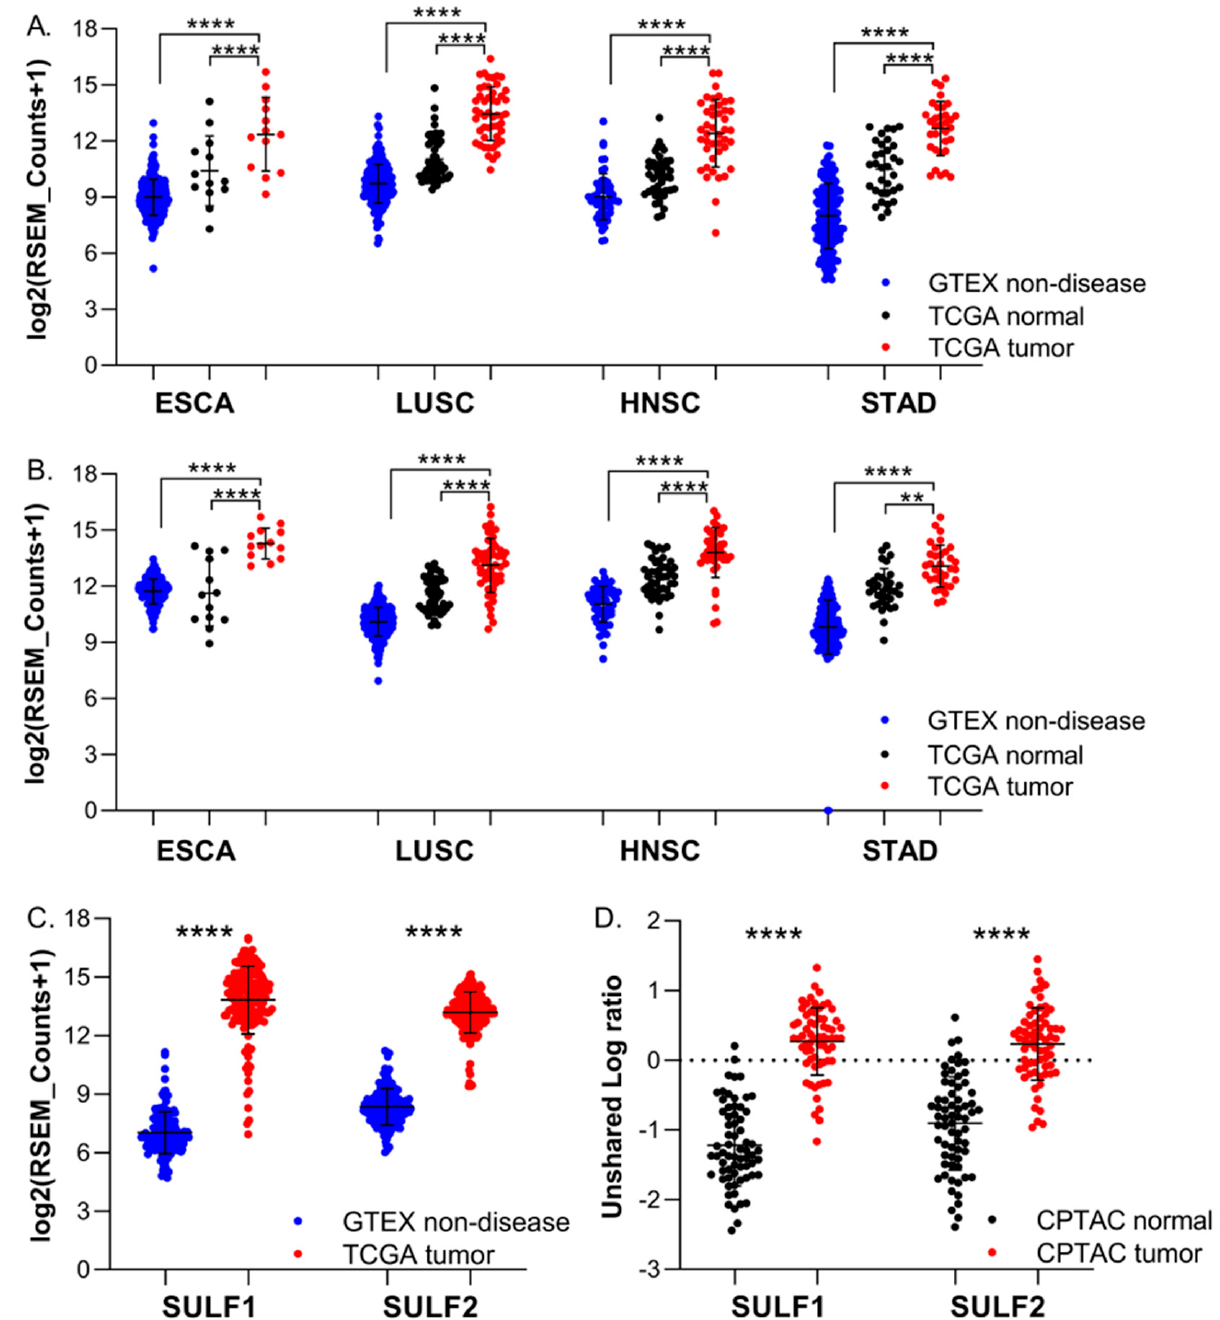
Figure 1. Expression of SULF1 and SULF2 in five cancer types. ( A ) SULF1 and ( B ) SULF2 mRNA in tumor compared with paired normal tissue of cancer patients in TCGA datasets and to non-disease tissues of healthy donors from GTEx; ( C ) SULF1 and SULF2 mRNA in the PAAD tumor tissues from TCGA compared with non-cancerous pancreatic tissue from GTEX. ( D ) SULF1 and SULF2 protein in the PDAC tumor and adjacent non-cancer tissues from CPTAC; p < 0.0001 (****), p < 0.01 (**).